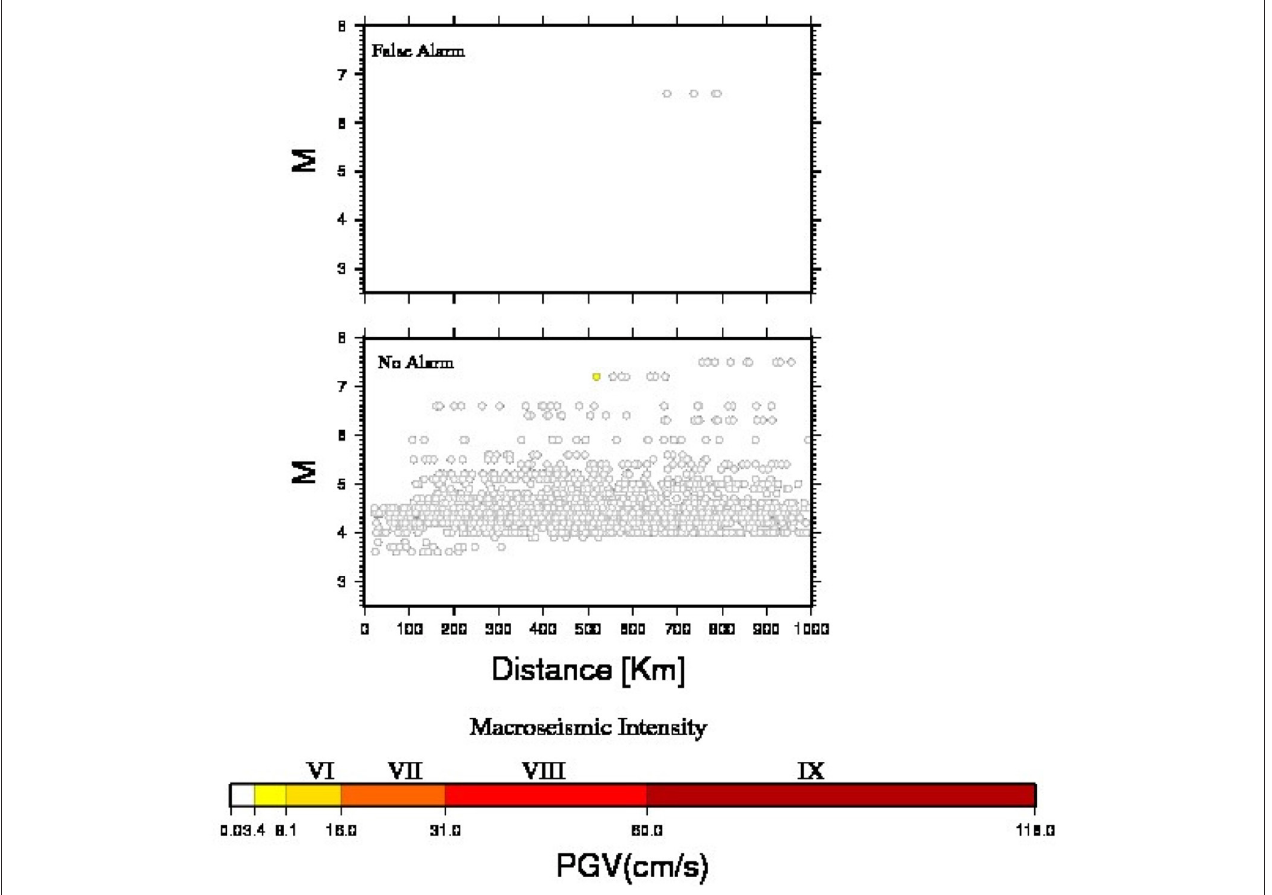
FIGURE 3 | The classification of each analyzed recording as a function of hypocentral distance and magnitude. The top plot represents the recordings for which a false alarm was issued. The bottom plot shows the events for which no alarm was sent out. Note that the observed PGA is always < 8.1 cm/s, although for one recording (the lone yellow point in the lower panel), this was above the 3.4 cm/s threshold, and hence should have been denoted with an ORANGE